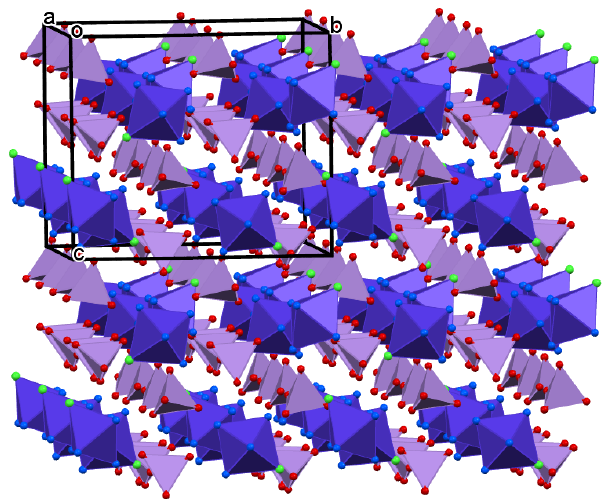
Figure 2. Parallel [Co(NH 3 ) 5 Cl] 2+ (dark violet octahedra) and MnO 4- (light violet tetrahedra) layers in the bc plane (view in the direction of the c axis).